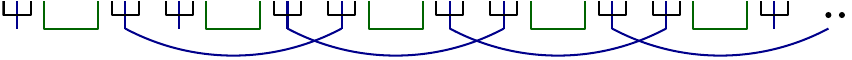
Figure 11 . Diagrammatic representation of the negativity for the pure two-tensor case.